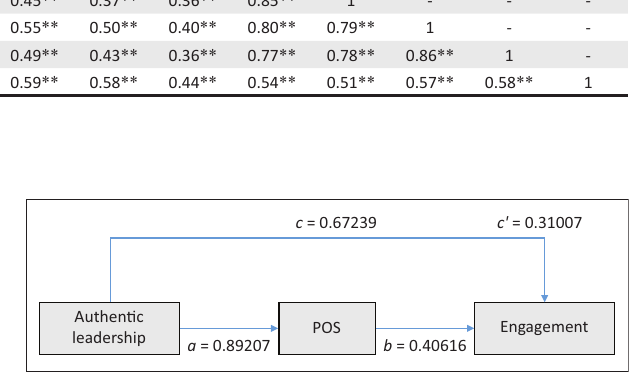
FIGURE 2: Results of statistical analysis of mediating